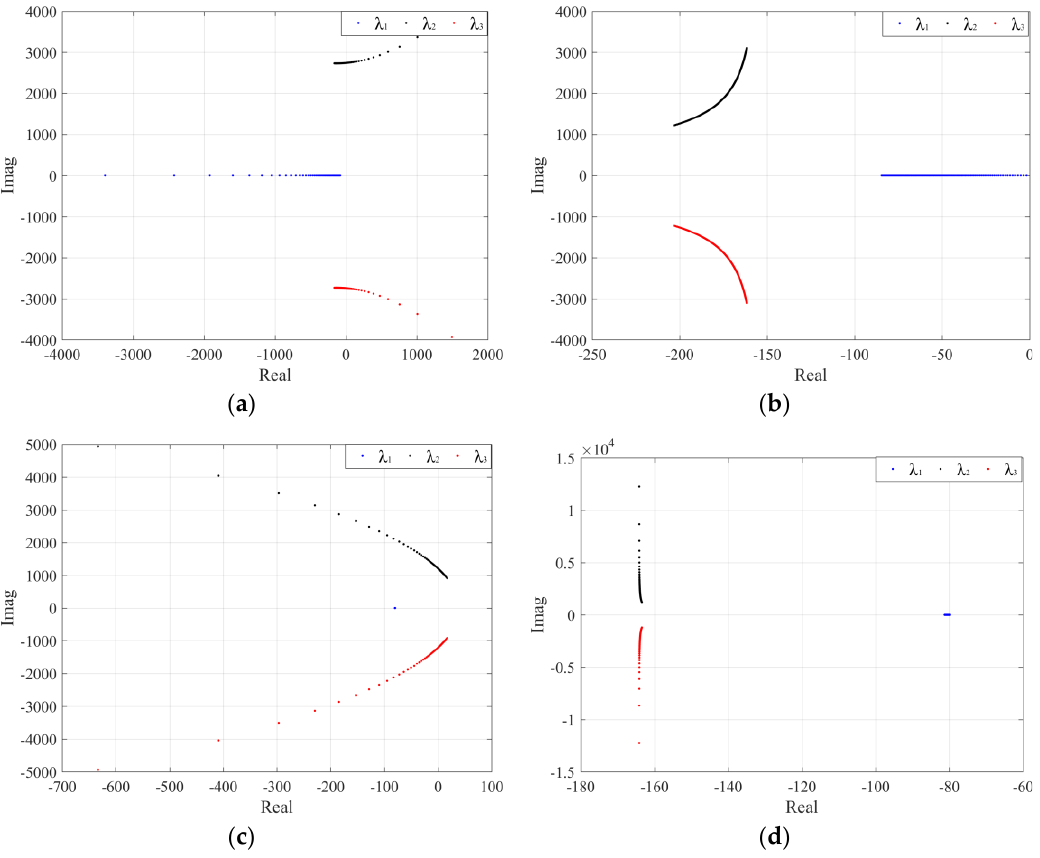
Figure 4. Loci of eigenvalue λ 1 , λ 2 , λ 3 as the changing of ( a ) T i 1 ; ( b ) K p 1 ; ( c ) C in ; ( d ) L b.